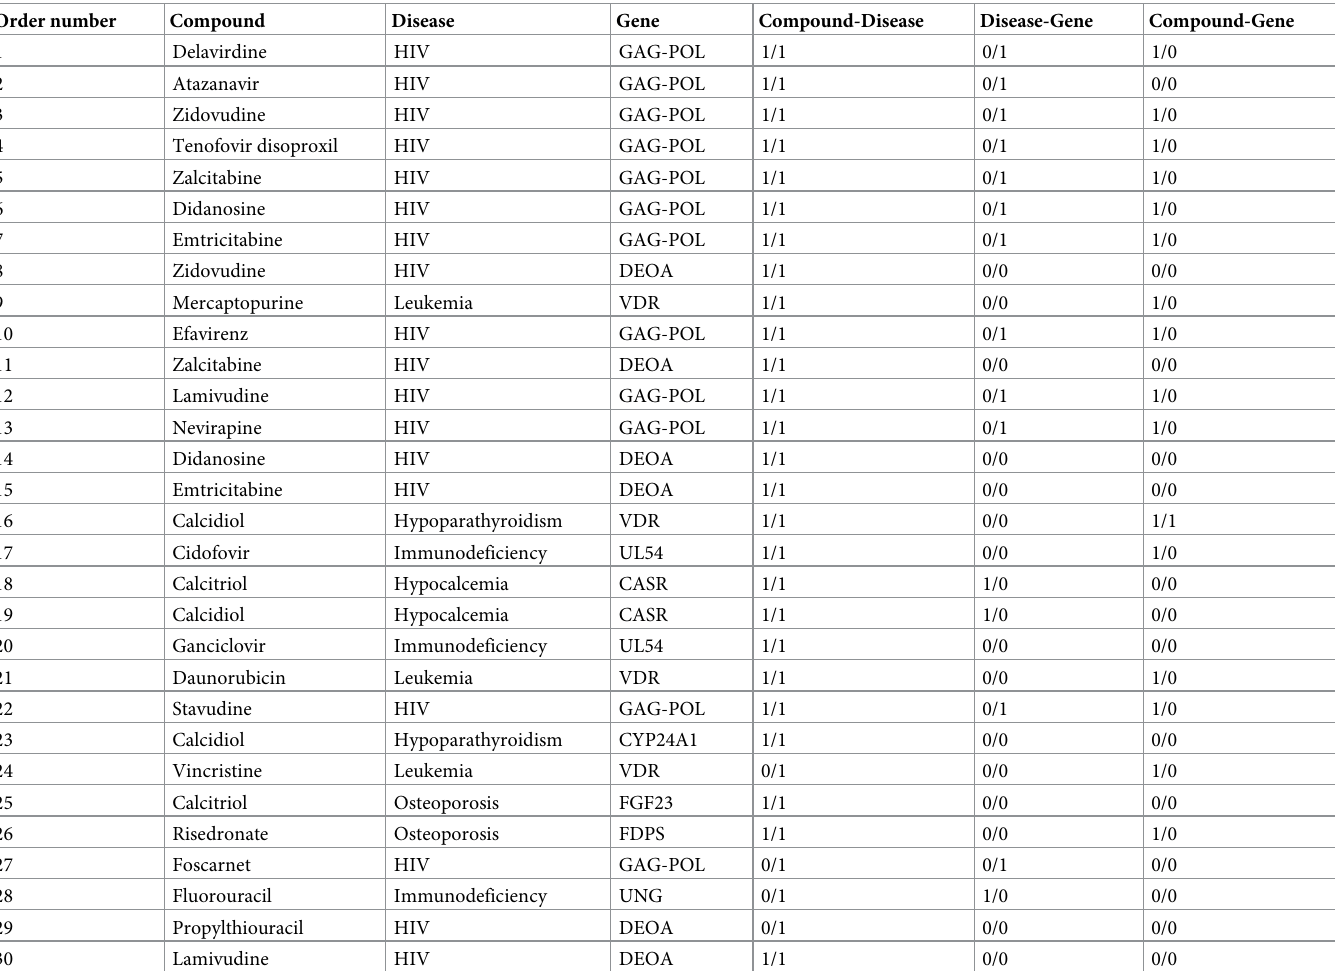
Table 9. Top 30 drug-disease-gene paths. The relations treat, caused by, and bind are associated with, respectively, drug-disease, disease-gene and drug-gene. The value x/y of indicates whether or not the relation exists in a data set: x = 1 indicates the presence of a relation in training or test sets; y = 1 indicates the presence of a relation in databases DisGeNET, DrugBank,